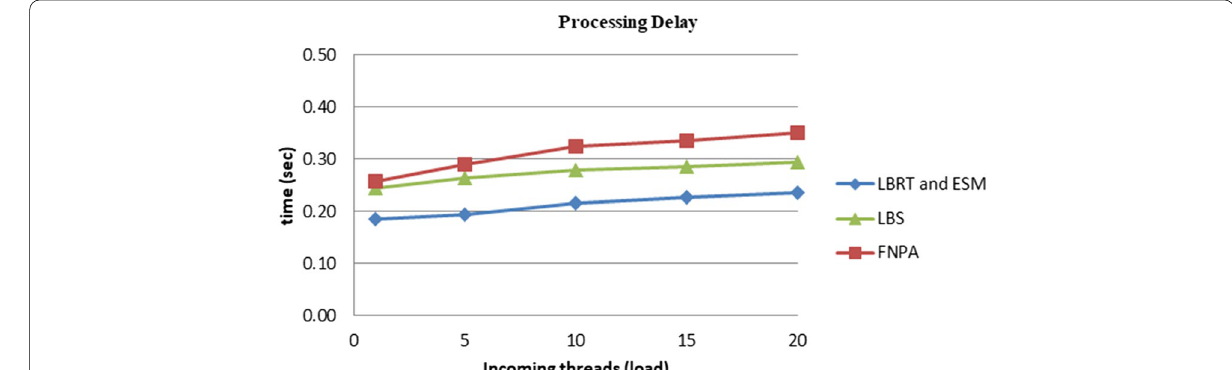
Fig. 10 Comparison of processing delay